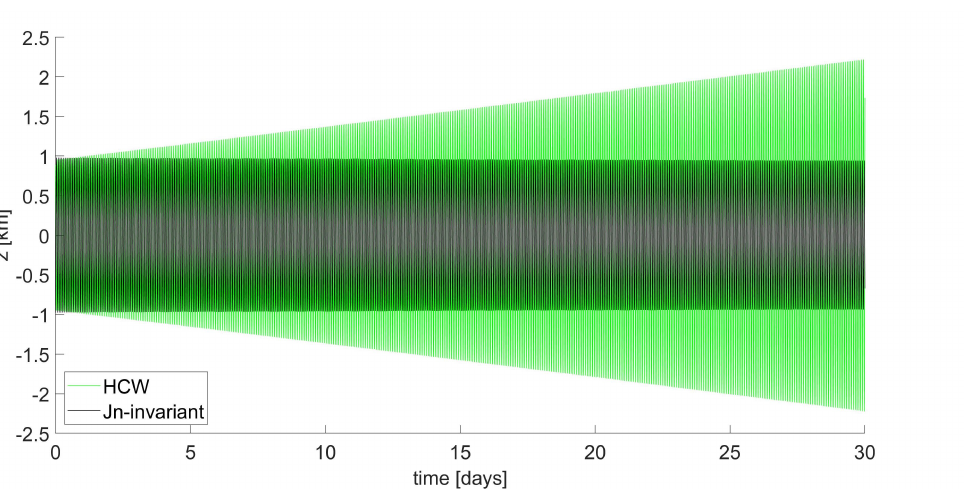
Figure 3. SSO formation: time behavior of y component.